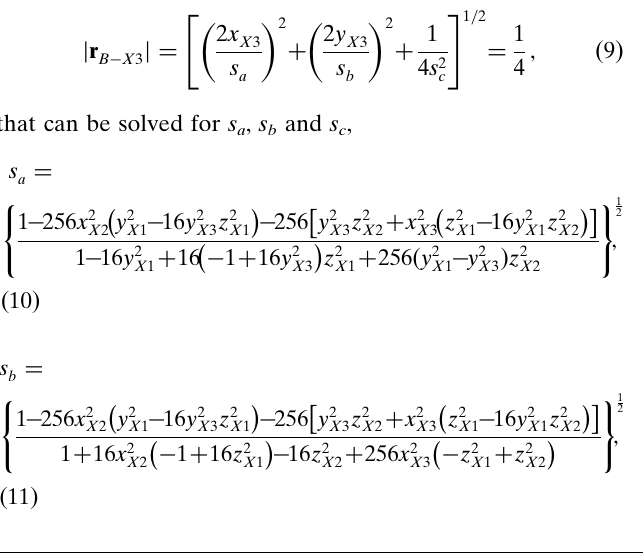
while the Glazer model is a 2 (cid:4) 2 (cid:4) 2 supercell (all our